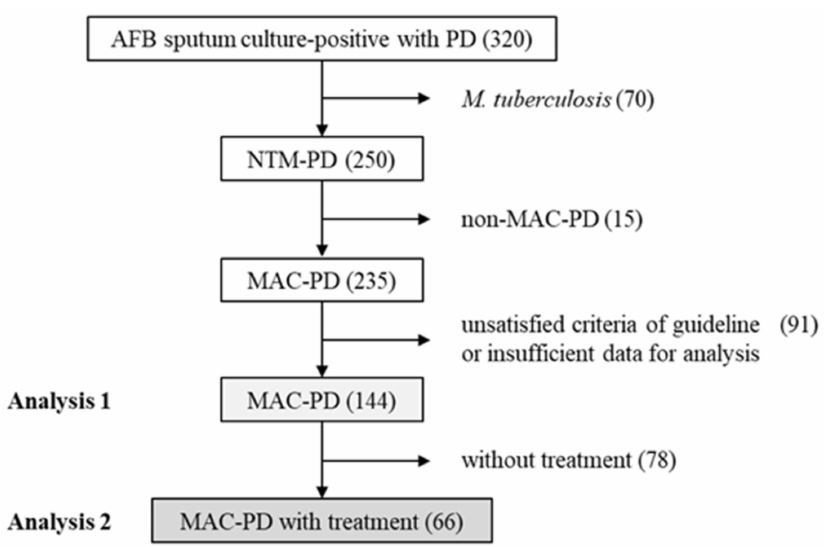
Figure 2. Flowchart of the study. NTM-PD, nontuberculous mycobacteria pulmonary disease; PD, pulmonary